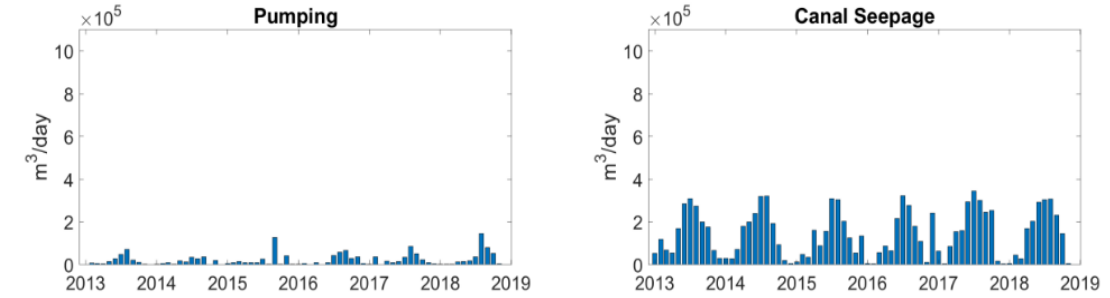
Figure 4. Time series plot of pumping, canal seepage, recharge ponds, and groundwater recharge rates from 2013 to